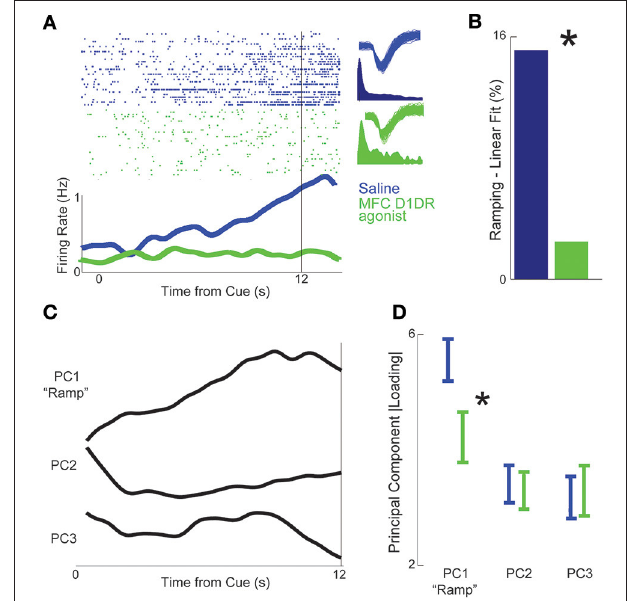
FIGURE 3 | MFC D1DR agonist attenuates ramping activity. (A) Example of an MFC ramping neuron recorded in control (blue) sessions. In green, the same putative neuron from the control session is shown in MFC D1DR agonist sessions. Top plot is a raster plot depicting the activity of a single neuron selected from each condition. Each row is a trial from the experiment and each dot is an action potential from a single neuron. (B) There was significantly less ramping activity in MFC D1DR agonist sessions, as identified by the number of neurons with a significant linear fit via regression. Statistical comparisons assumed that independent populations were recorded in control and D1DR blockade sessions. (C) Principal component analysis in control sessions revealed that ramping activity was the most prominent pattern of neural activity among MFC neurons (PC1). (D) To directly compare ramping activity, we projected PCs from control sessions onto MFC D1 agonist sessions. PC1 explained significantly less variance in MFC D1DR agonist sessions, while PC2 and 3 were unchanged. Asterisk represents significance at p < 0.05 via a t -test. All statistics treated each session independently. Taken together, these data suggest that MFC D1DR agonist attenuates ramping activity of